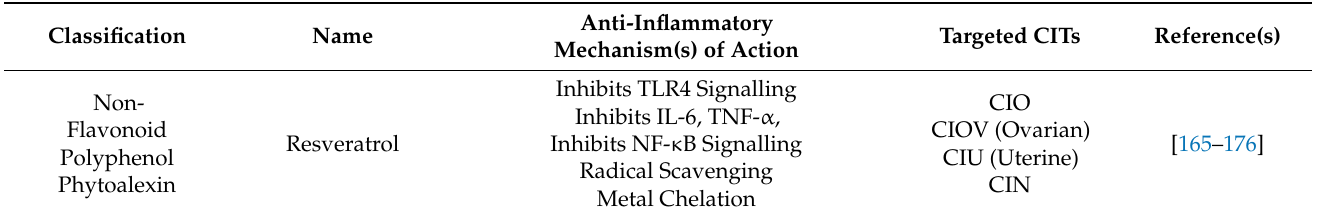
Table 1. Examples of Prospective Natural Anti-Inflammatory CIT